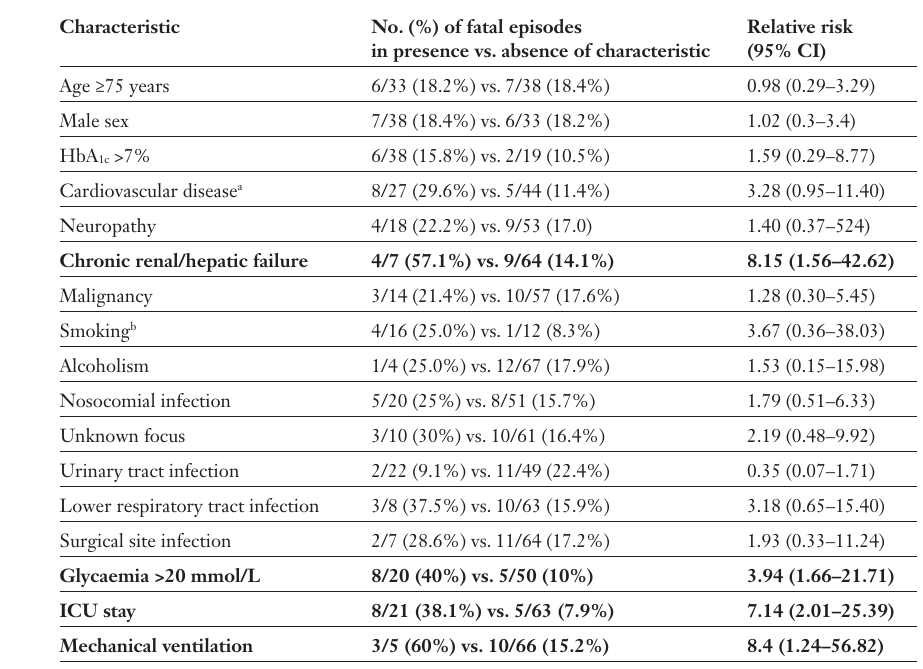
Univariate analysis of risk factors for fatal outcome of bloodstream infec- tion in 71 diabetic